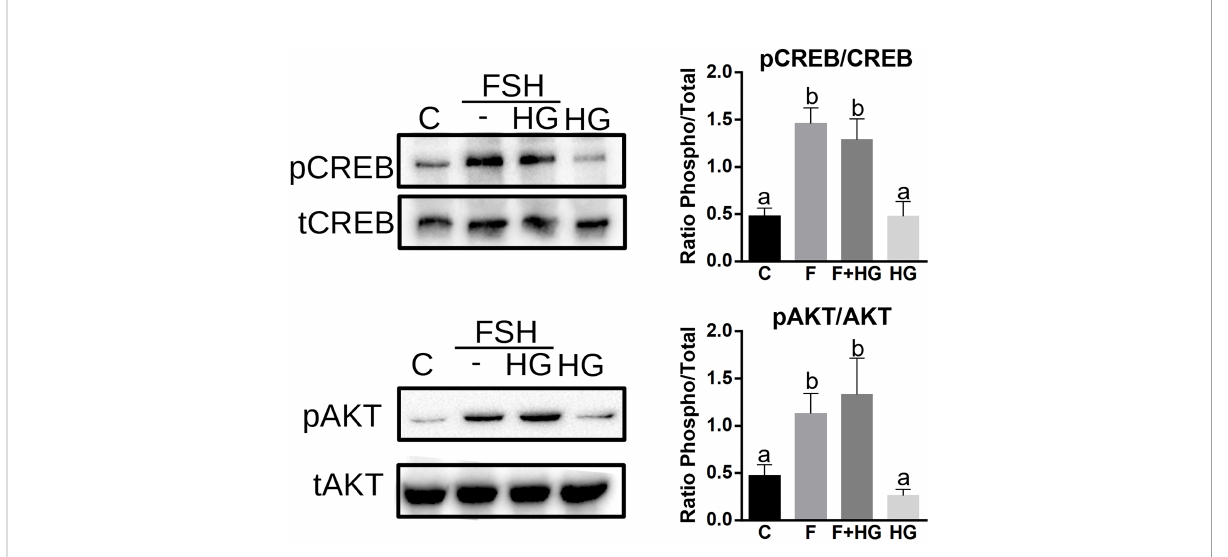
FIGURE 5 SIK inhibition does not increase CREB or AKT phosphorylation. Cultured rat GCs were pretreated with HG (0.5 µM) for one hour and then stimulated with FSH for one hour. Whole-cell lysates were used for total CREB, phospho-S133-CREB, total AKT, and phospho-S473-AKT determination by Western blotting. The experiment was repeated 3 times, a representative blot is shown. For all experiments, bands were quanti fi ed and the ratio of phospho to total protein was calculated, the average ± SEM is plotted on the right. One-way ANOVA followed by Tukey. Columns labeled with different letters differ signi fi cantly a-b p < 0.05, n =